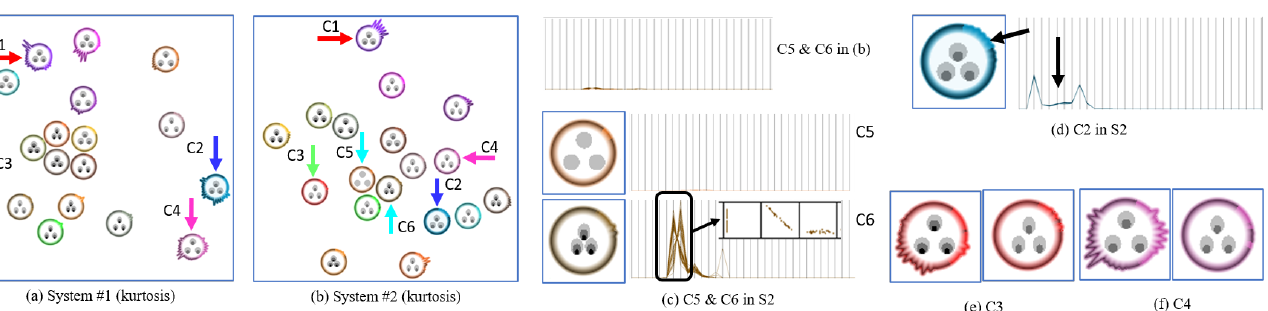
Figure 12. Cluster visualization with two OS datasets from System #1 (S1) and System #2 (S2). ( a ) S1 data with kurtosis metric ( b ) S2 data with kurtosis metric ( c ) Cluster C5 and C6 in S2 with parallel coordinates display ( d ) Cluster C2 in S2 with parallel coordinates display ( e , f ) Cluster C3 and C4 (left: S1, right: S2). The color corresponds to the cluster. See Supplement for larger versions of the